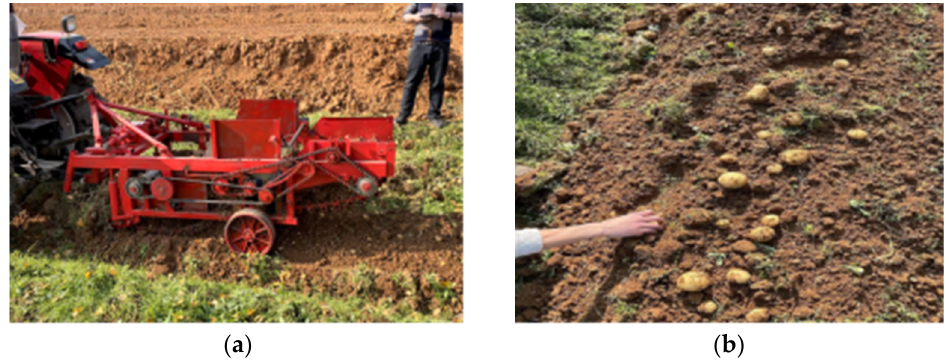
Figure 13. Field harvesting test. ( a ) Modified prototype; ( b ) harvesting effect.